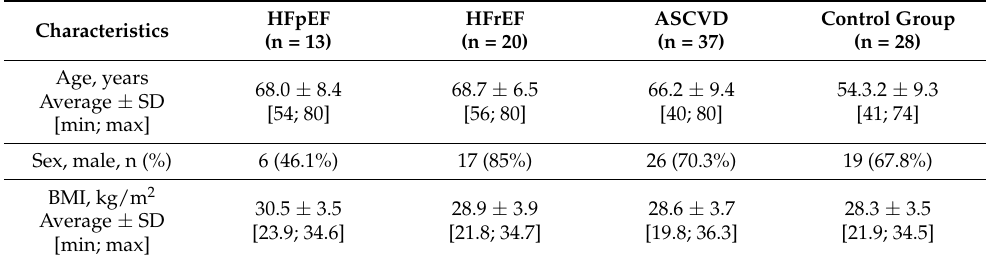
Table 4. Baseline characteristics of patients for qPCR analysis, FS extraction method.